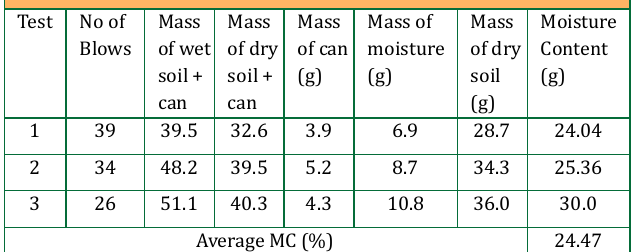
Table 5 (b): Liquid Limit Test result